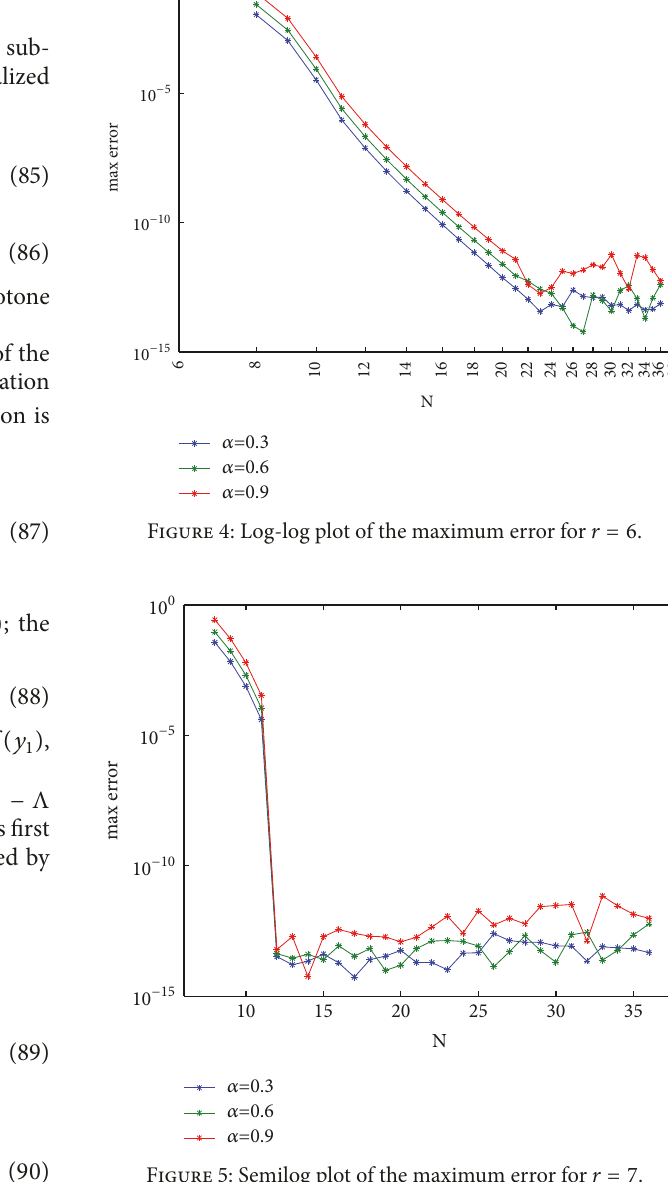
Figure 5: Semilog plot of the maximum error for 𝑟 = 7